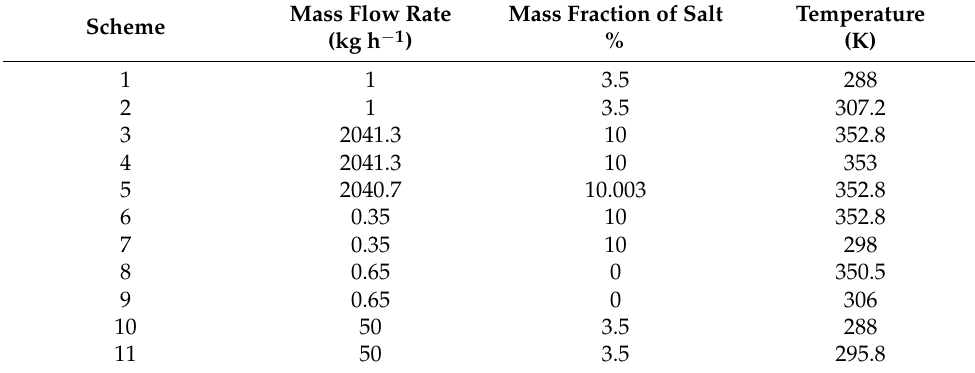
Table 2. Mass and energy balance, shell side feed. Inner radius 350 um, thickness 300 um, R / a